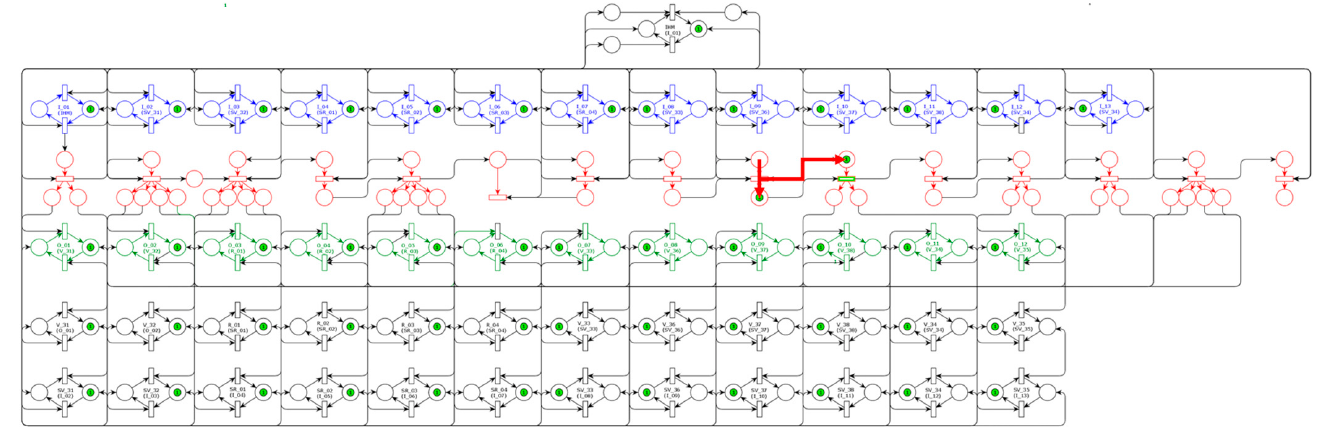
Figure 28. Algorithm’s 11th step—Rocket engine test.